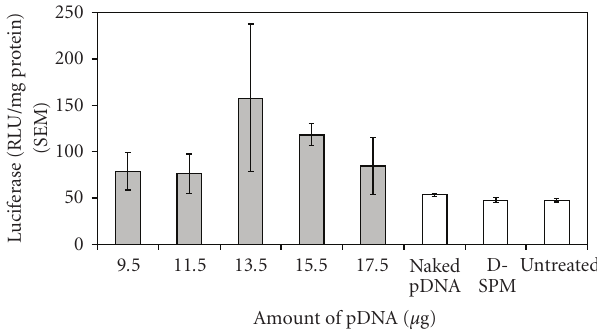
Figure 6: Luciferase expression (RLU/mg protein) in the trachea and lung of BALB/c mice following the administration of D-SPM complexed with di ff erent amount of pCIKLux, at 2 days post- treatment. The w/w ratio was kept at 16. Untreated mice were served as the control. Data are presented as mean ± S.E.M from 6